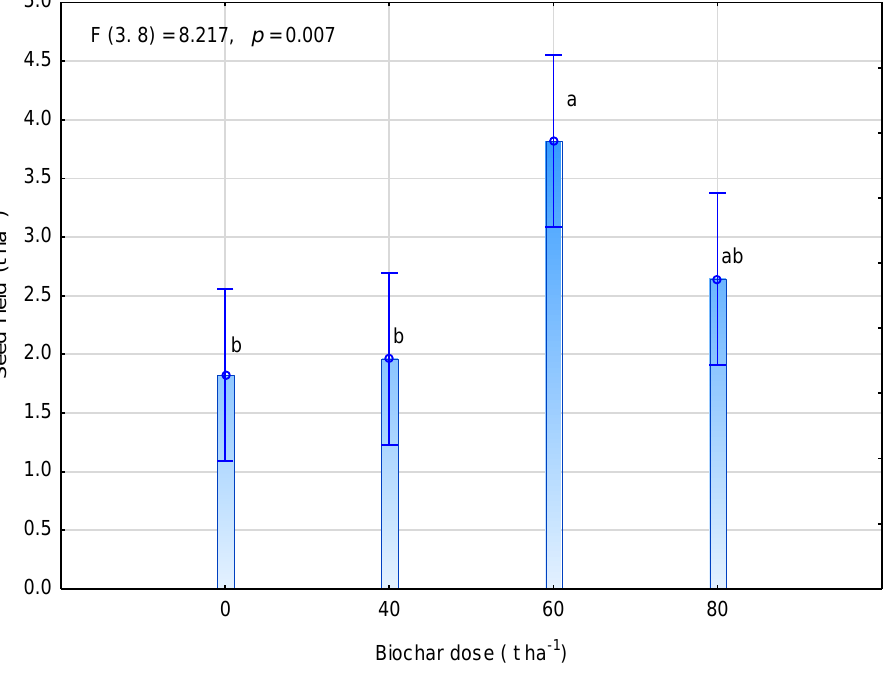
Figure 7. Height of the first pod setting depending on the level of biochar fertilization. 4. Discussion Our results showed that biochar application increased soil respiration compared with the control treatment, which is in contradiction with several studies based on short-